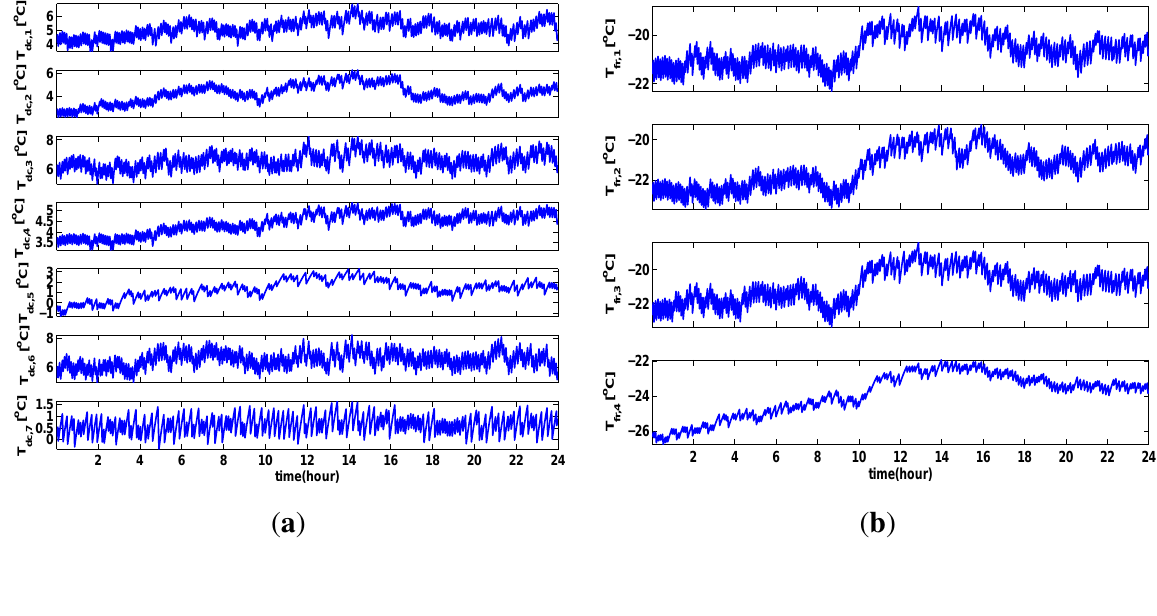
Figure 15. Cold reservoir temperatures are changed by supervisory controller to regulate the power/energy consumption. ( a ) Display case temperatures; ( b ) Freezing room